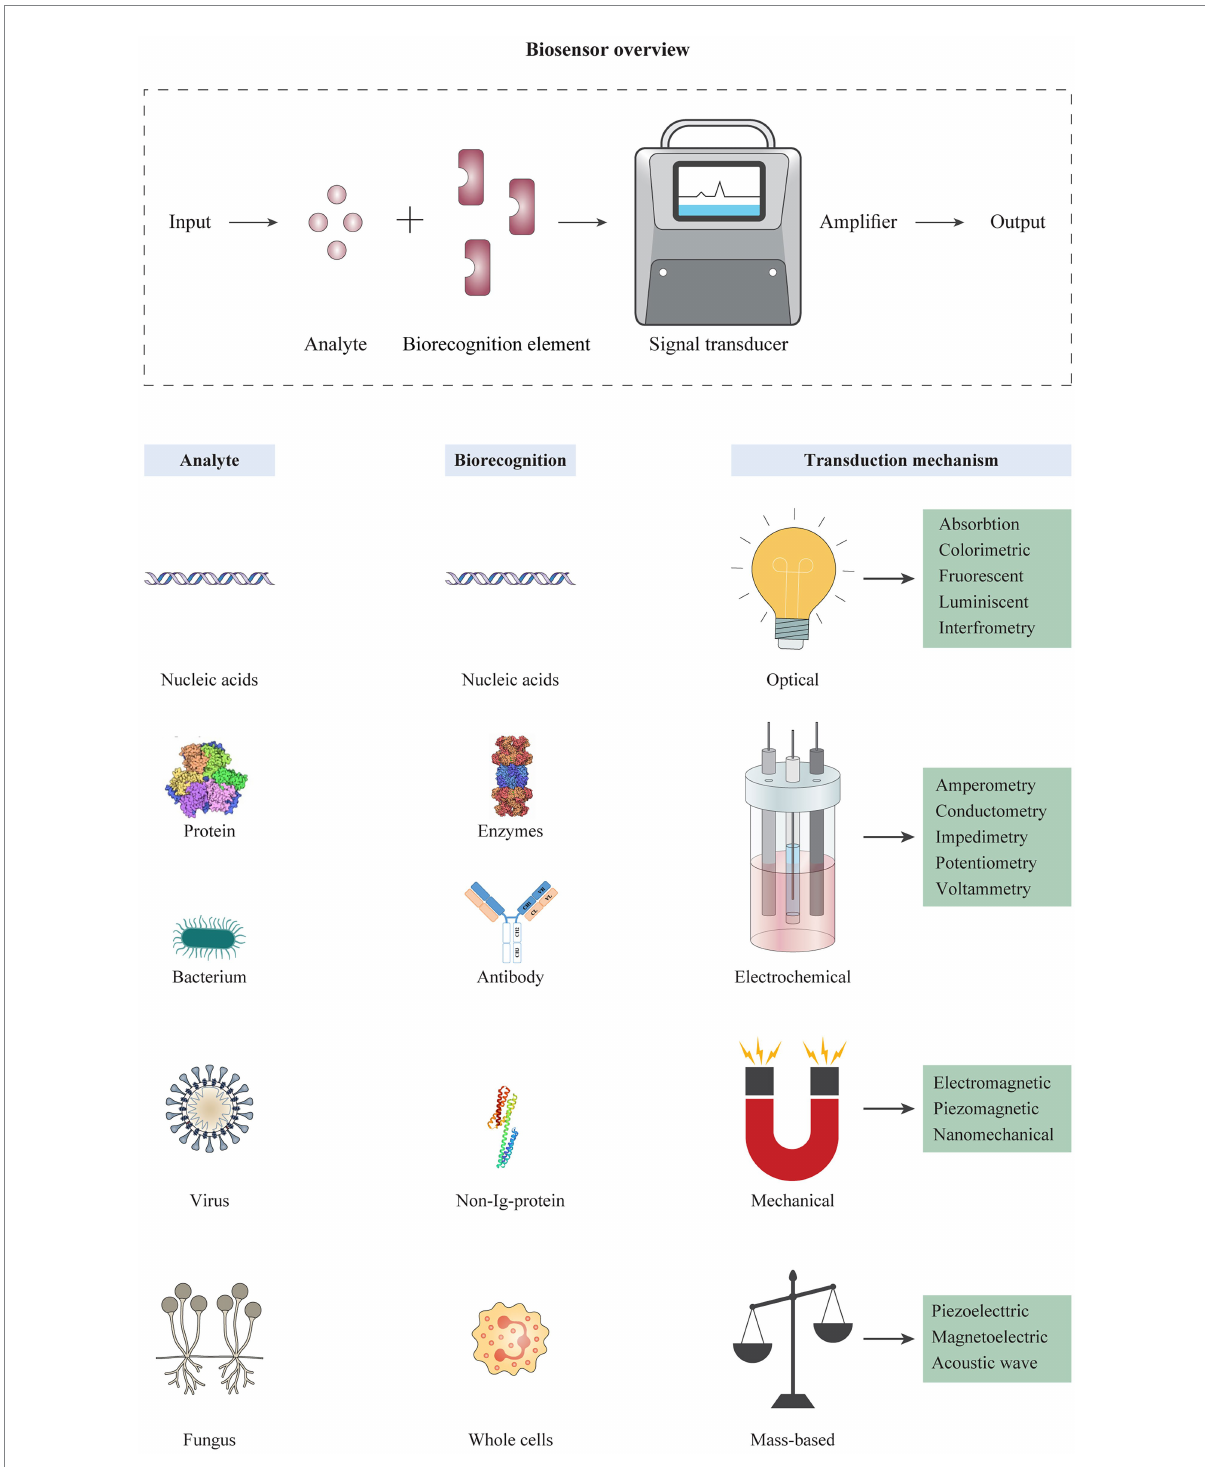
FIGURE 3 Schematic overview of biosensor platforms consisting of different types of analytes, biorecognition elements, and transduction mechanisms. The operation of a biosensor is based on detection of an analyte by a highly specific biorecognition element. Analytes usually include biomolecules such as nucleic acids, proteins, and different cells. The reaction of an analyte with the biorecognition element is transformed into an electrical, optical, or electrochemical signal by a transducer, and converted into displayable data. The different types of biorecognition elements are used in the design of biosensors, including nucleic acids, antibodies, non-long-proteins, and/or synthetic ligands. Biosensors can be categorized based on the transducing mechanism, including optical, electrochemical, mechanical, and mass-based biosensors, which each category contains several